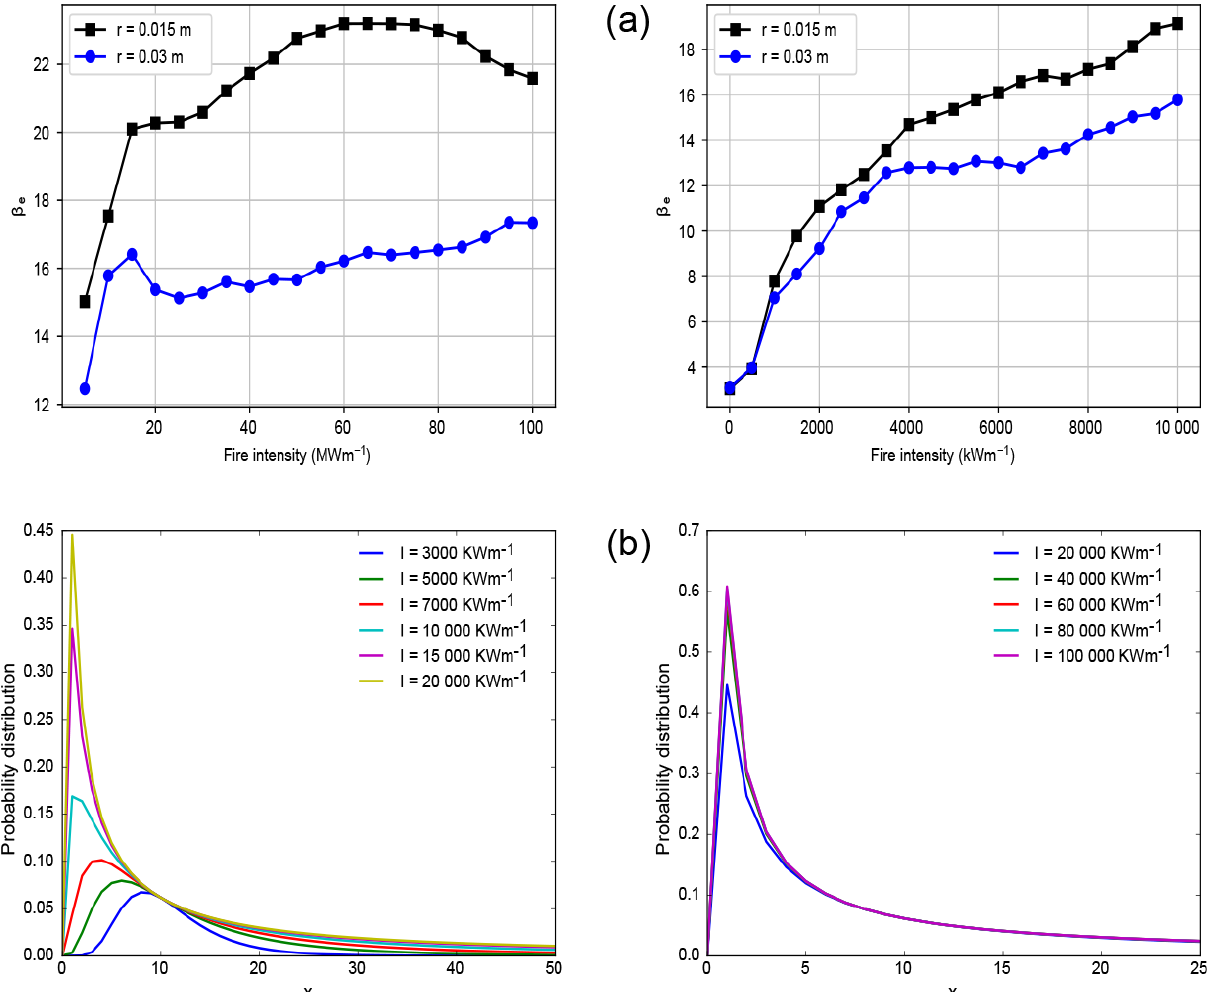
Figure 5. (a) Line plot showing the sensitivity of the formulation to different values of fire intensity over constant wind conditions (10ms − 1 ) and a constant firebrand radius (0 . 015m). The sensitivity is measured in terms of the total increase in the burned area when both fire spotting and turbulence are included over the case when no random effects are considered. The parameter β e is defined as β e = ( x random − x no-random )/ x no-random . The diffusion coefficient D is 0 . 15m 2 s − 1 . (b) The line plots show the lognormal distribution for selected values of fire intensity I but constant values of wind speed U = 10ms − 1 and firebrand radius r = 0 . 03m. According to the physical parameterisation, the plots can also be interpreted as the behaviour of the lognormal distribution for varying values of the parameter µ and a constant value of the parameter σ